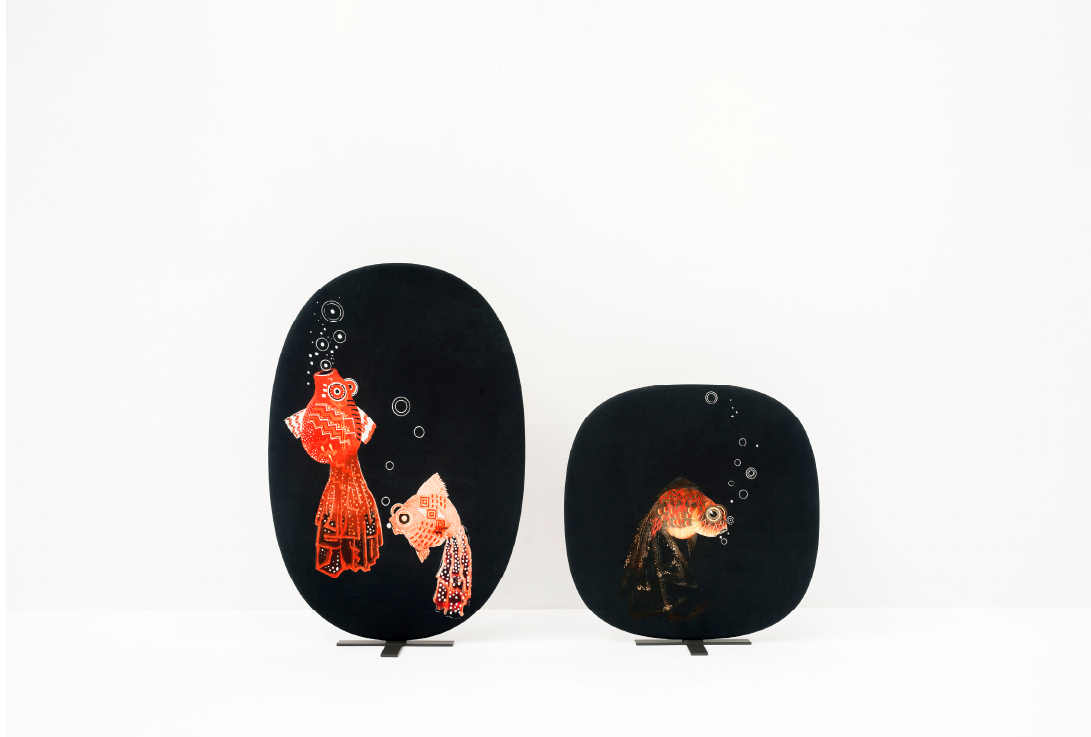
Figure 3. Nebula Poissons Textiles with Jean Dunand décor by Pearson & Lloyd (2017), by Tacchini. Ph. Andrea Ferrari, on Tacchini’s official